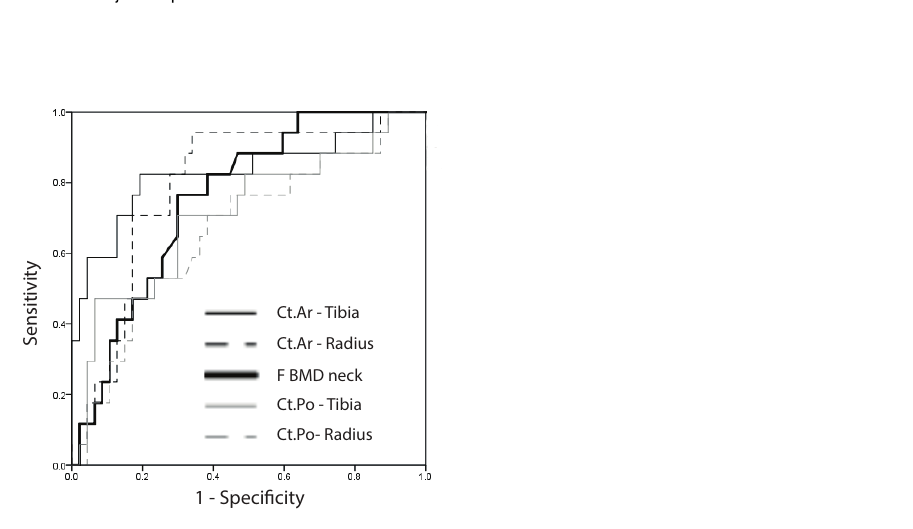
Fig 3. ROC curves:F neck BMD, Ct.Ar, and Ct.Po of tibia and radius discriminating fracture. Higher area under the curve (AUC) indicates a more favorablesensitivity-specificity profile. The ROC curves of Ct.Po (radius and tibia) are comparedto the ROC curves with the highestAUC among HR-pQCT parameters (Ct.Ar of radiusand tibia) and densitometric parameters (F neck BMD). For exact AUC values see Table 4; De-Long comparisons of ROC curves: Tibia: Ct.Po vs. Ct.Ar: p = 0.19; Ct.Po vs. F BMD neck: p = 0.6; Ct.Ar vs. F BMD neck: p = 0.27; Radius: Ct.Po vs. Ct.Ar: p = 0.2; Ct.Po vs. F BMD neck: p = 0.34; Ct.Ar vs. F BMD neck: p = 0.59; ROC: receiver-operating-characteristic; Ct.Po: cortical porosity; Ct.Ar: cortical area; BMD: bone mineral density; F: